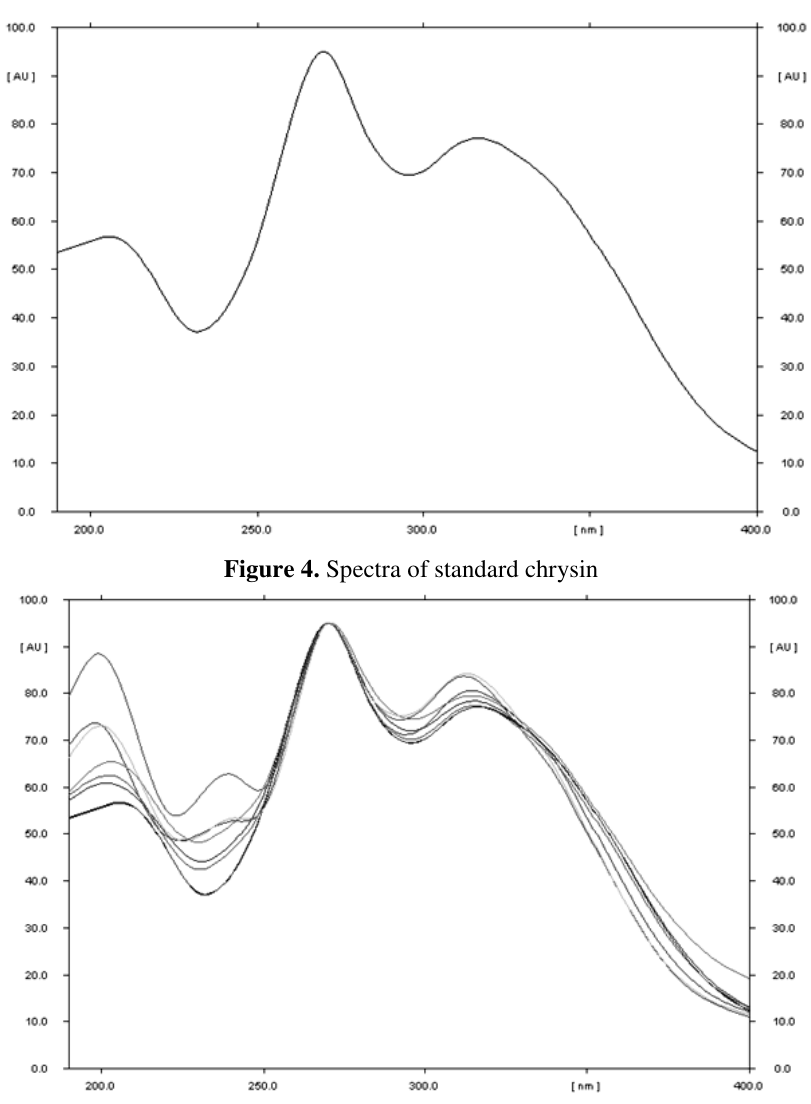
Figure 4. Spectra of standard chrysin